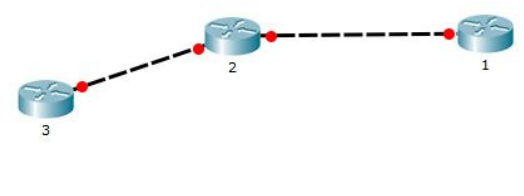
Figure 1. Two node pairs activate another node pair for more efficient routing. Node pairs 1 − 2 and 2 − 3 should activate node pair 1 − 3 to establish a direct link between nodes 1 and 3 and to avoid configuring lightpaths 1 − 2 and 2 − 3 . This would ensure more effective lightpaths usage and reduce utilization of computing resources of Router 2. Inhibition (the corresponding W ij value example such situation is visualized in Figure